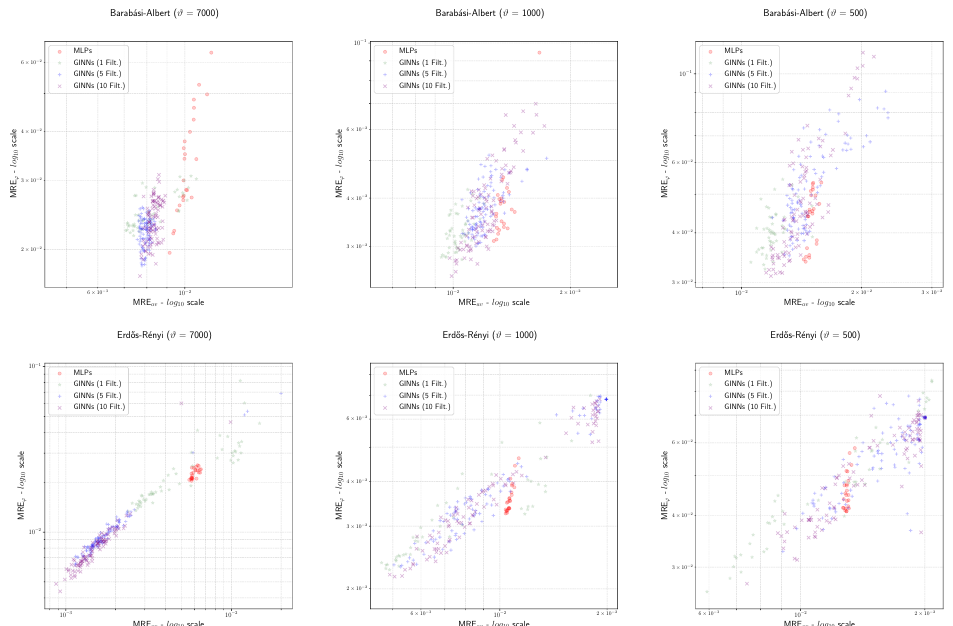
Figure 8. Scatter plots in the ( MRE av ,MRE ϕ ) plane for NNs trained with respect to ( bottom ). Left to right: NNs trained with ϑ = 7000,1000,500 samples. Red circles: MLPs; green stars, blue crosses and purple “x”: GINNs with F = 1,5,10, respectively. We do not plot results with NNs that have a relu activation function or a mini-batch size equal to 128.